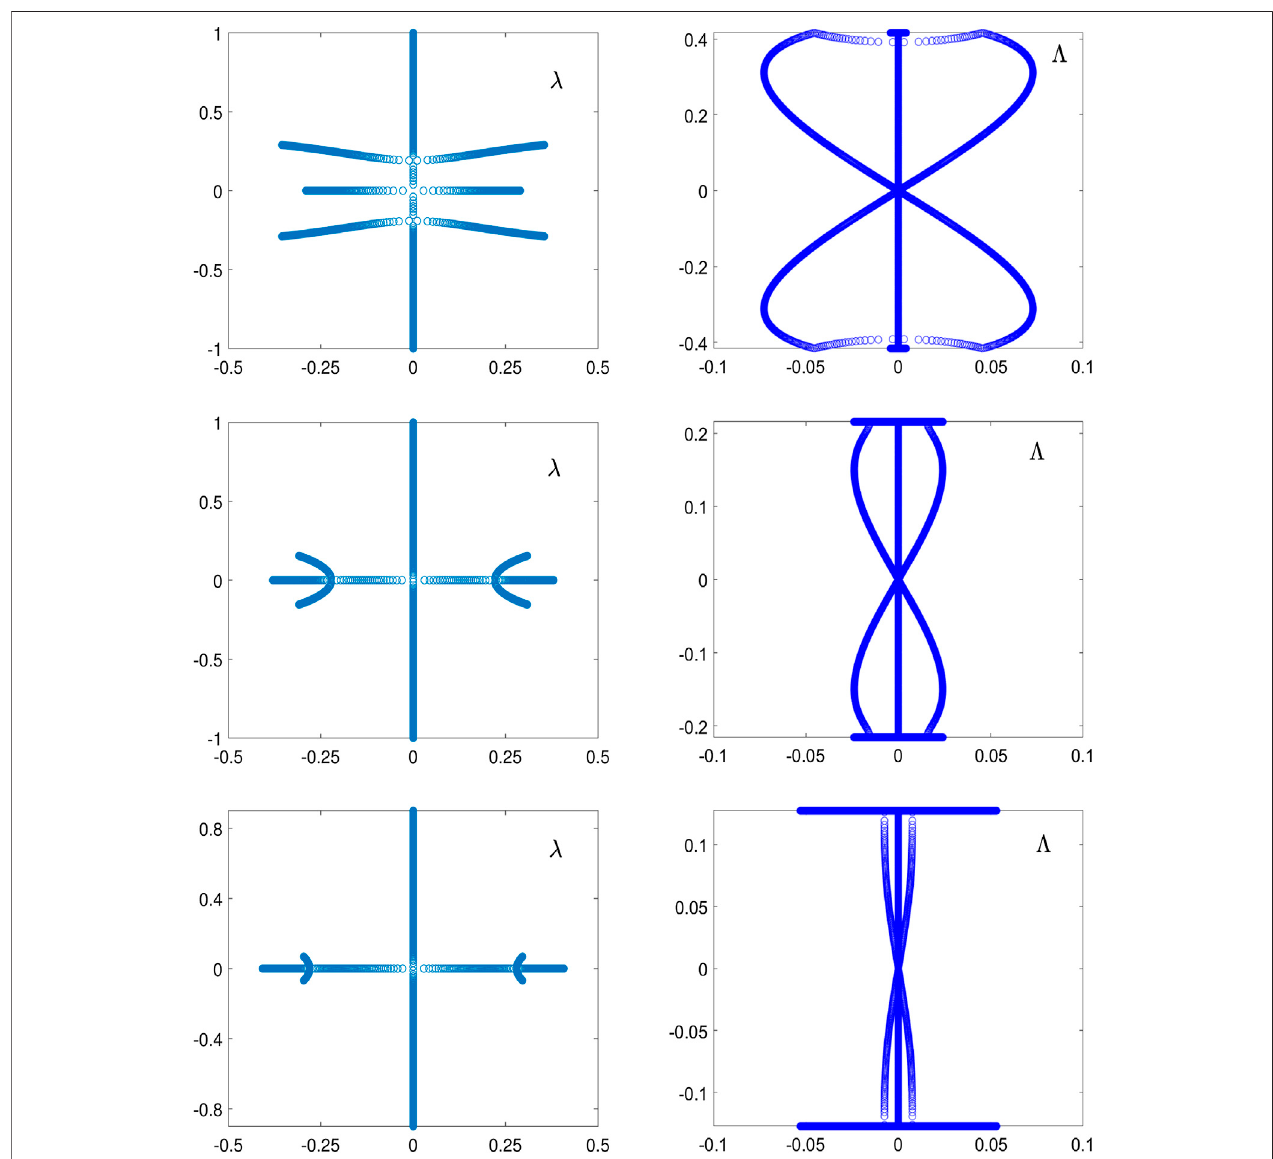
FIGURE 6 | The same as Figure 5 but for the amplitude-normalized double-periodic wave (2.16) with k (cid:2) 0 . 3 (top) , k (cid:2) 0 . 6 (middle) , and k (cid:2) 0 . 9 (bottom) . Figure 4 compares the instability rates for different standing waves of the same unit amplitude. Re ( Λ ) is plotted versus the (cid:19) in Eq. 3.4 . For the dn-periodic wave Floquet parameter θ in (cid:18) 0 , π L (left), we con fi rm that the growth rate is maximal for the constant-amplitude wave ( k (cid:2) 0 ) and is monotonically decreasing as k is increased in ( 0 , 1 ) . For the cn-periodic wave (right), the growth rate is also maximal in the limit k → 0, for which the amplitude-normalized cn-periodic wave is expanded as